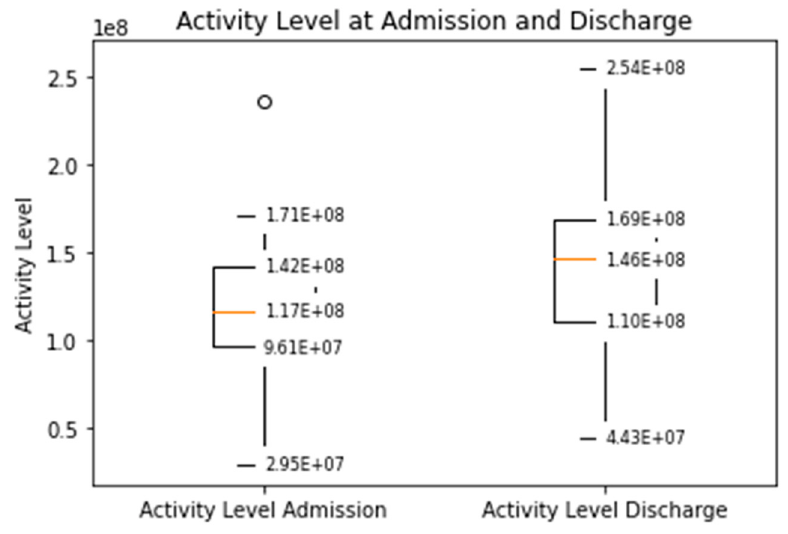
Figure 2. Median daily activity level measured by the WCD at the time of admission and discharge to the CR clinic (Increased from a median 117 × 10 6 (IQR 96 × 10 6 –142 × 10 6 ) TVE to 146 × 10 6 (110 × 10 6 –169 × 10 6 ), p < 0.001).